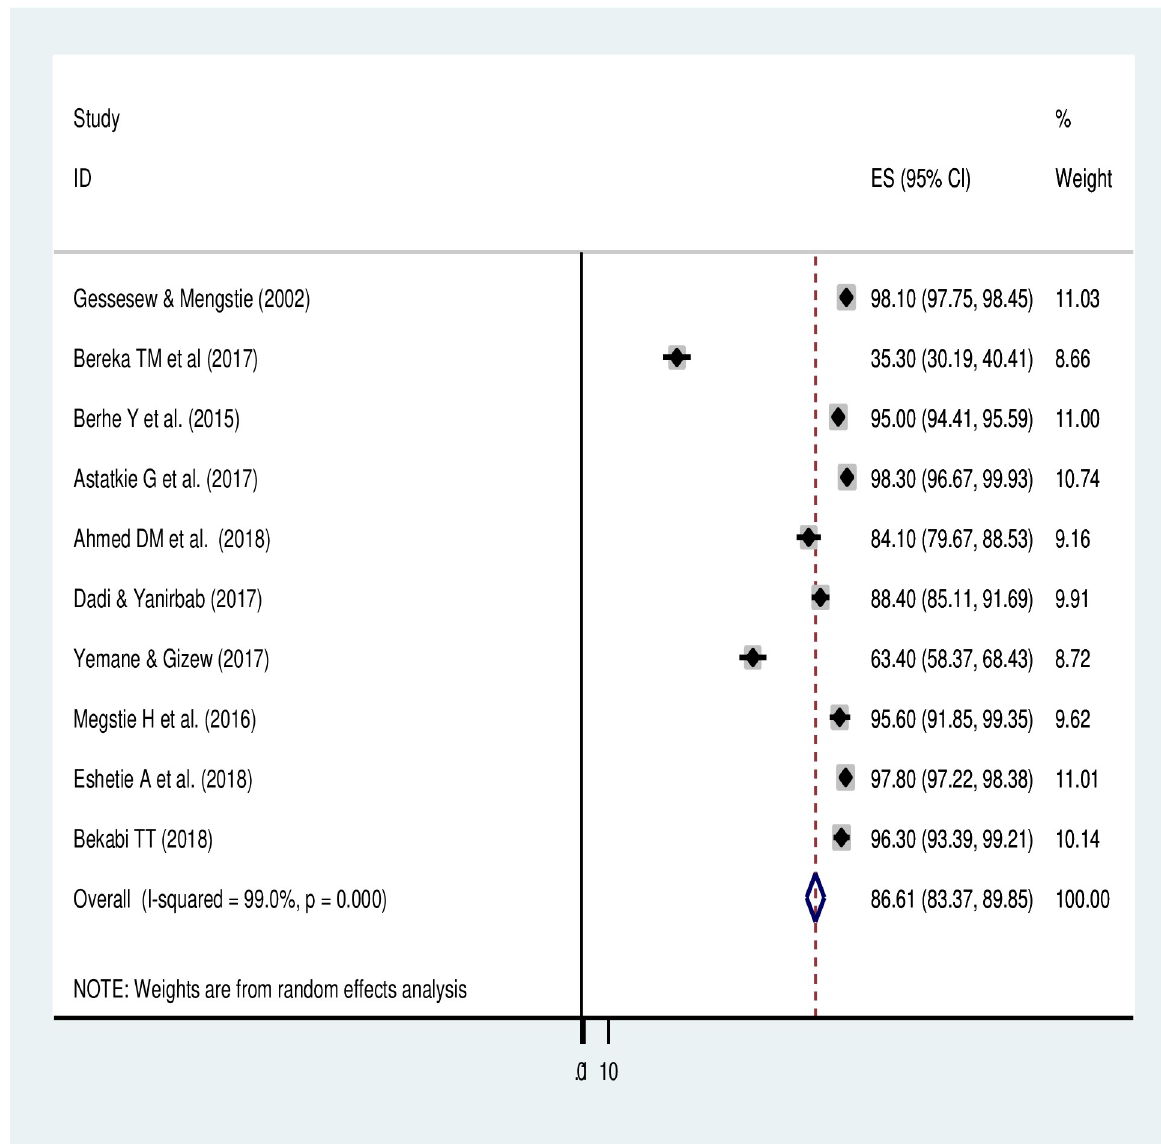
PLOS ONE | https://doi.org/10.1371/journal.pone.0245977 April 22,